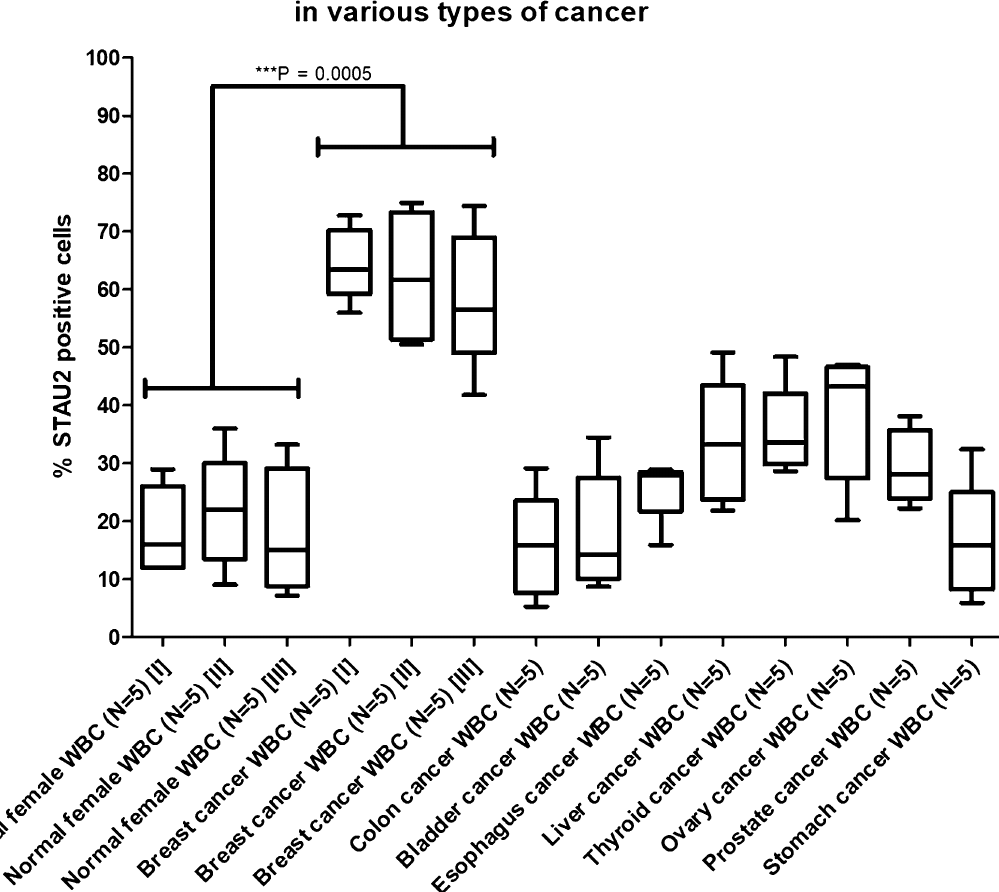
Figure 6. The percentage of fluorescently labelled T and B-cells in various types of cancer, including breast, colon, bladder, oesophageal, liver, thyroid, ovarian, prostate and stomach cancer. The results from normal female and breast cancer samples were randomized into groups I–III. The results demonstrate that STAU2-positive cells were exclusively identified in breast cancer samples ( p = 0.0005). However, some cancers exhibit a low level